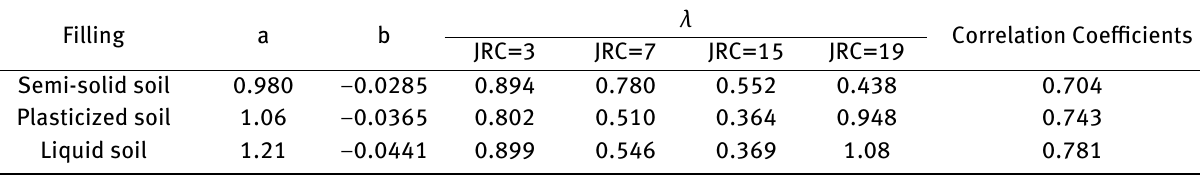
Table 2: The value of λ in different filling